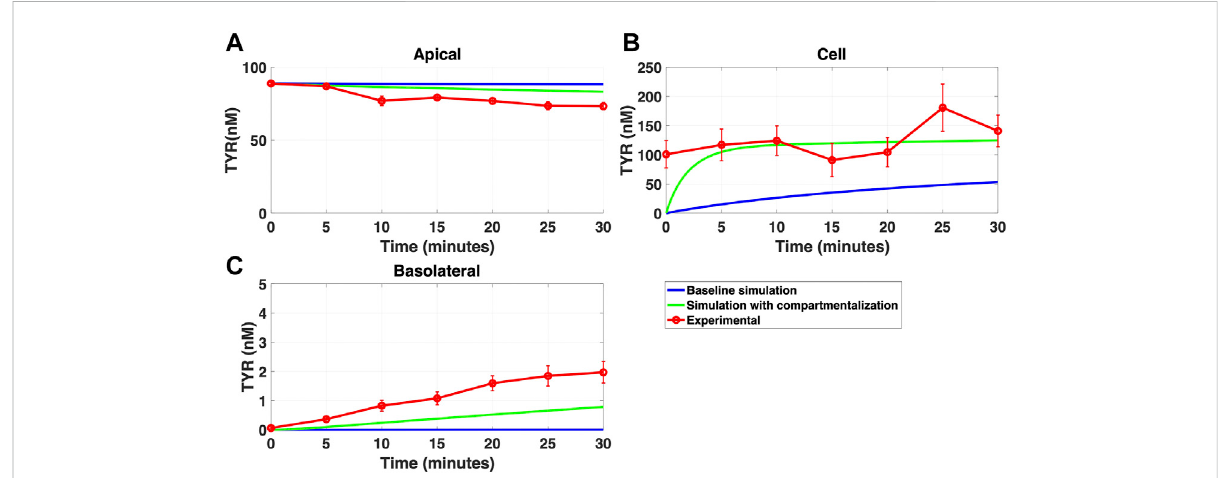
FIGURE 11 Compartmentalization is needed with introduction of symmetry in the facilitated diffusion transporters with apical loading. The transport of 88.9 nMTYRacrossCaco-2cellswasmodeledfollowingapicalloadingbysolvingEqs12 – 14,usingthevaluesmentionedinSupplementaryTableS2, using MATLAB vR 2021a. Comparisons were made between the models (baseline = blue curve; modi fi ed = green curves) and experimental observations;red curve (Sarkar and Berry,2020)for the apical Panel 11 (A) , cellular Panel 11 (B) and basolateral compartments Panel 11 (C) . When symmetry is introduced in the facilitated diffusion transporters, compartmentalization is needed. Kinetic parameters used for this modelling were: